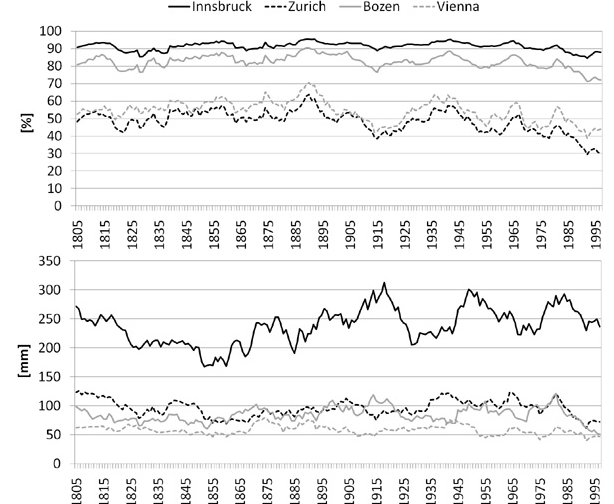
Figure 3. Time series of the 11 year running mean for the percent- age [%] (upper plot) and amount [mm water equivalent] (lower plot) of solid precipitation for winter seasons (DJF). Displayed are the time series of 4 gridpoints located near the cities Innsbruck (black solid line), Zurich (black broken line), Bozen (grey solid line) and Vienna (grey broken